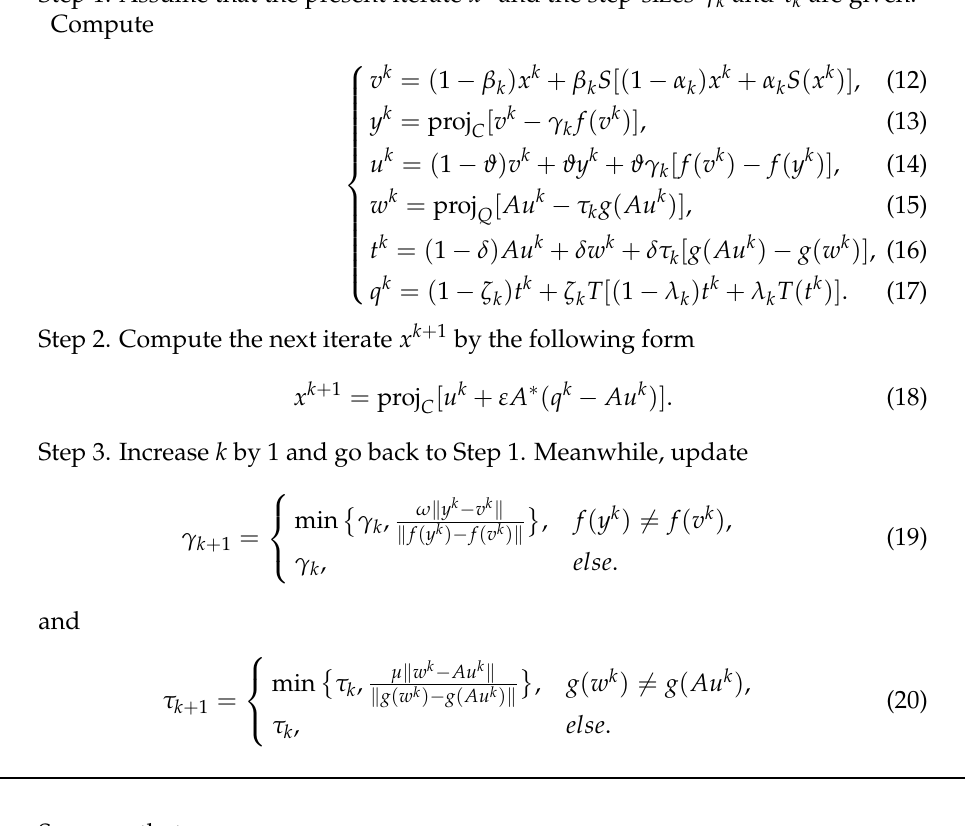
Algorithm 1: Select an initial point x 0 ∈ C . Set k =